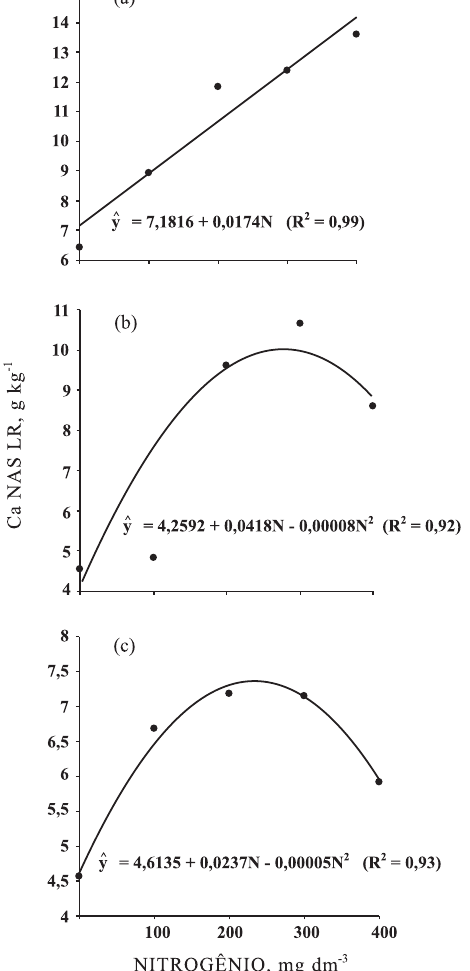
Figura 2. Teor de cálcio nas lâminas de folhas recém- expandidas (LR) do capim-marandu, no primeiro (a), segundo (b) e terceiro (c) cortes, em função das doses de nitrogênio.